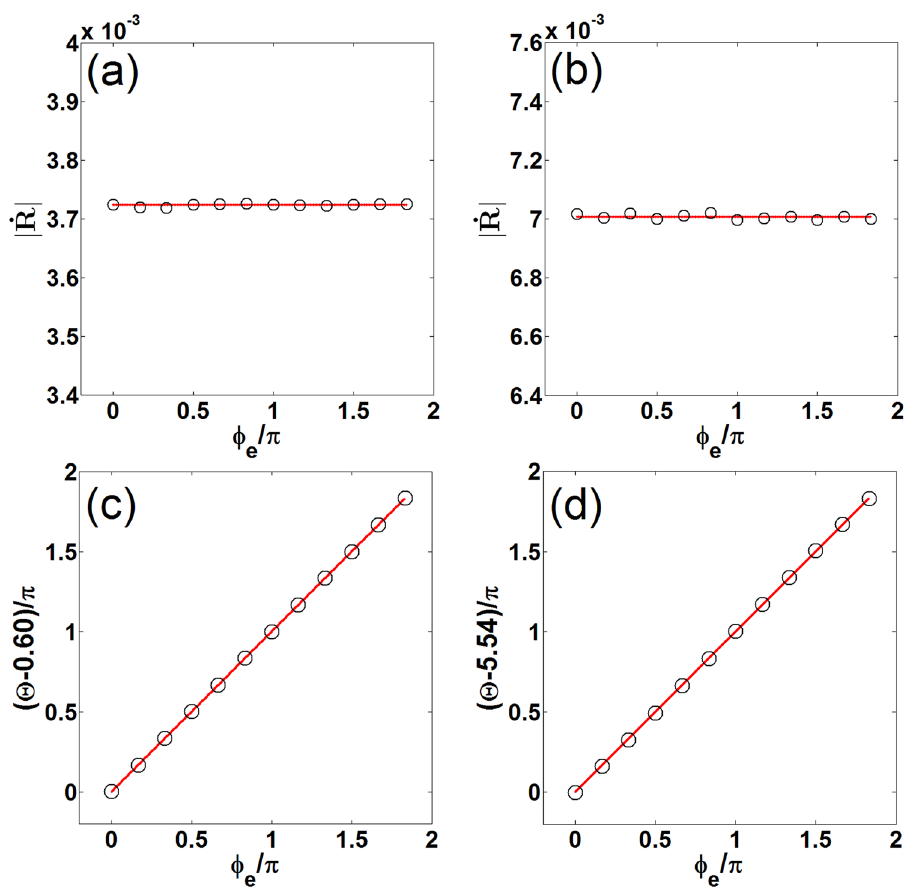
Figure 3. Drift velocity as a function of φ e in the presence of an ac electric field with ω e = 2 ω and Φ = 0. Top row: Theoretical (lines) and numerical (circles) drift speed vs φ e . Bottom row: Theoretical (lines) and numerical (circles) drift angle vs φ e . Left column: Highly excitable medium. Right column: Weakly excitable